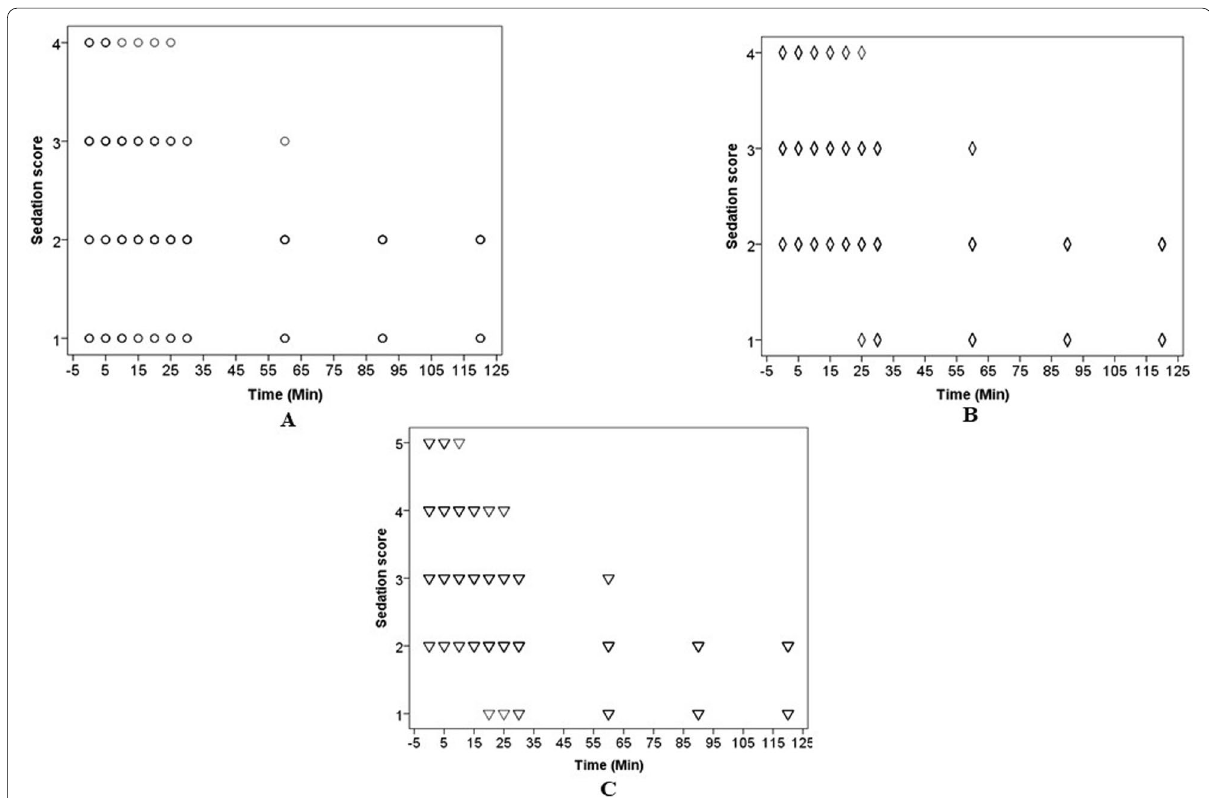
Fig. 4 Graph showing trends of postoperative sedation